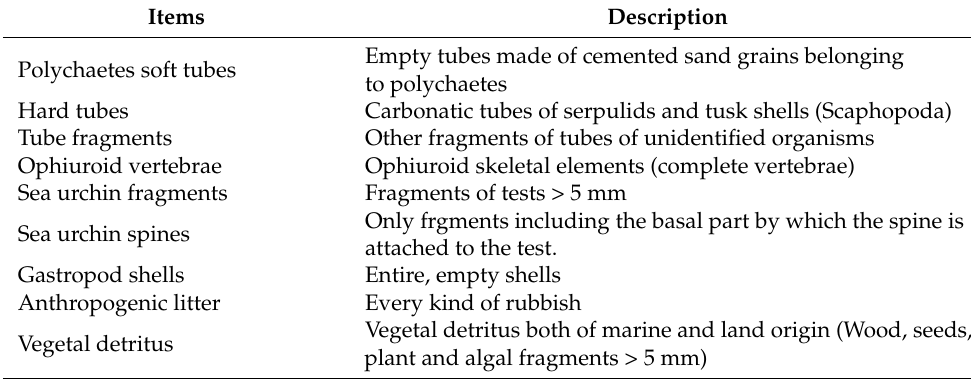
Table 2. Categories of non-living